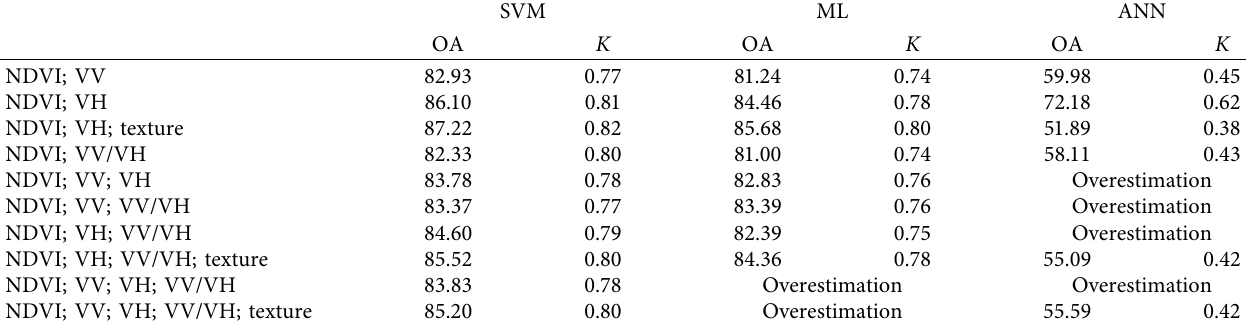
Table 5: Overall accuracy and Kappa indices of combined